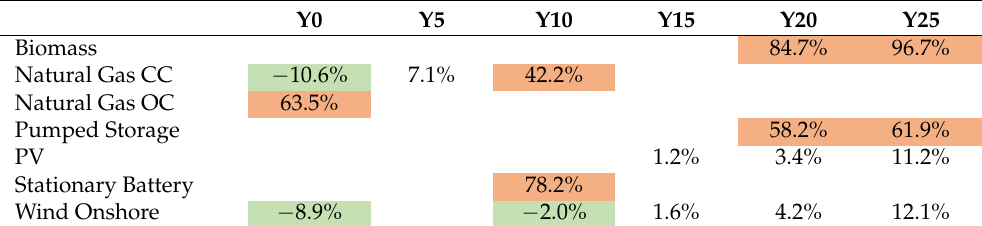
Table 4. Margin gap of invested technologies over their lifetime in the perfect foresight case (profitable investments marked green, very high gaps marked red).